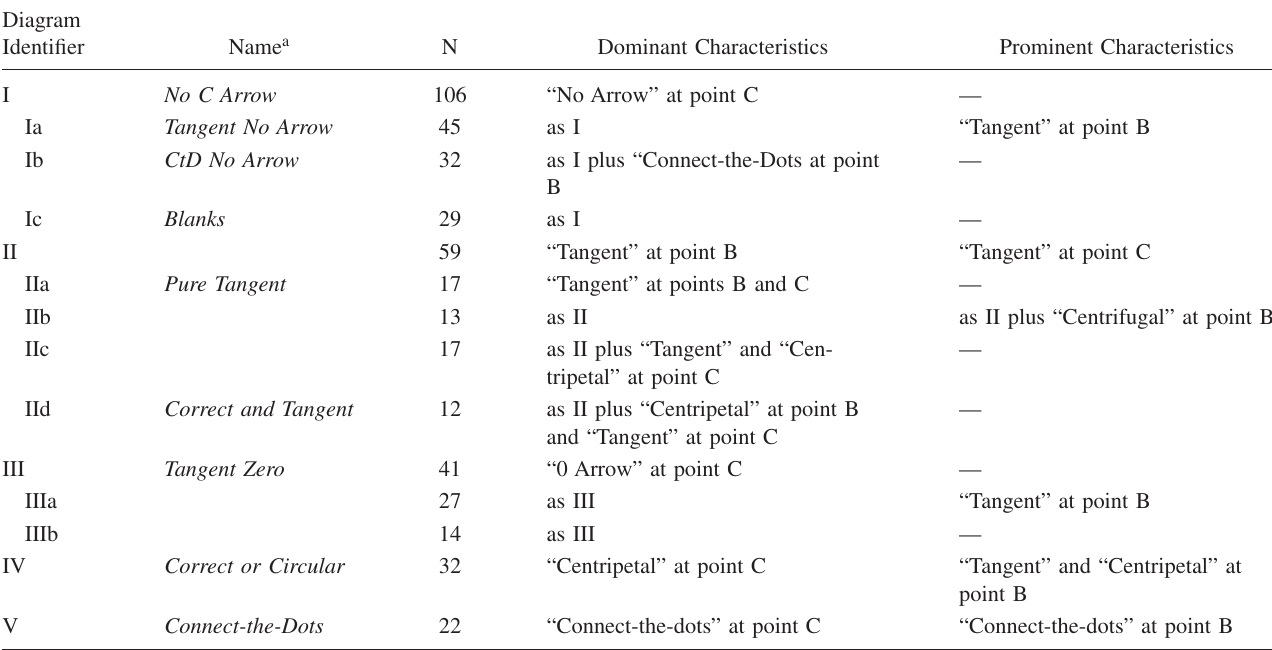
TABLE I. Groups found by the clustering algorithm.